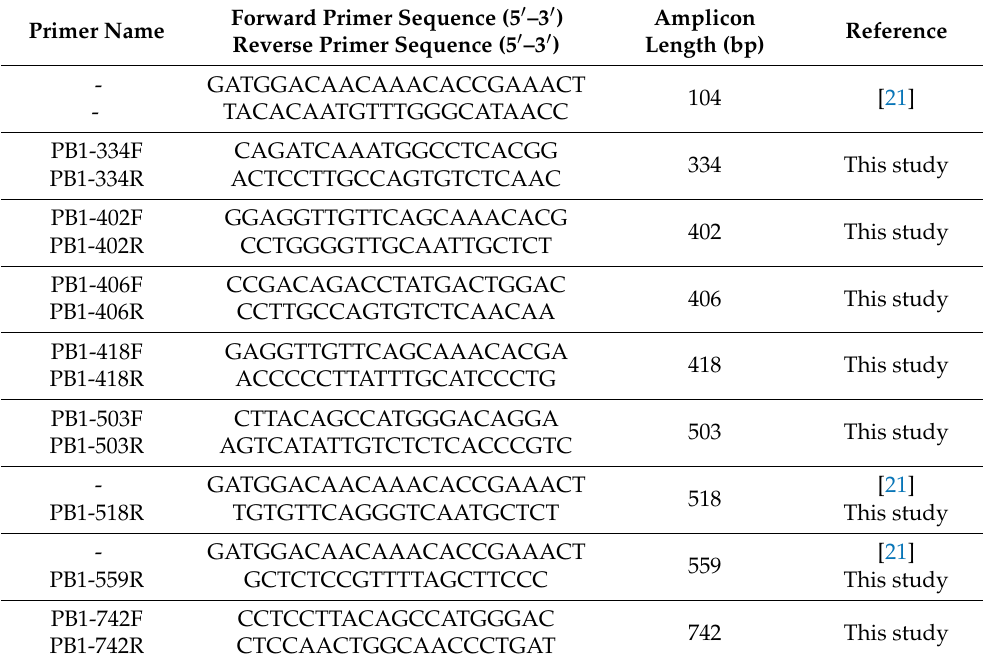
Table 1. Primers to amplify the influenza A virus polymerase basic protein 1 ( PB1 ) gene. Primer